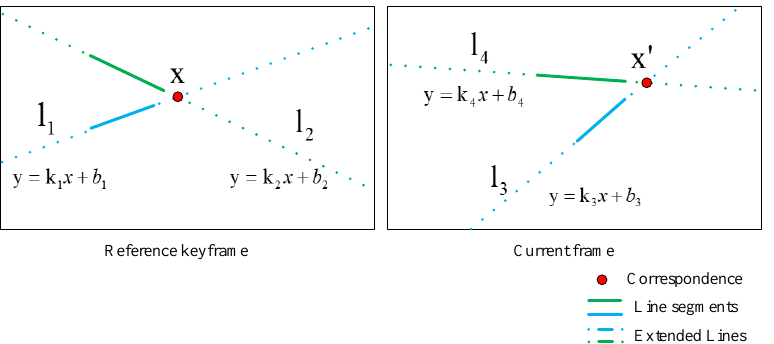
Figure 2. Illustration of the LSVI matching points. The line segments and the corresponding extended lines (shown in the same color) represent the matched line segments and the corresponding extended lines. k m ( m = 1,2,3,4 ) and b n ( n = 1,2,3,4 ) represent the slope and intercept of the line l m ( m = 1,2,3,4 ) , respectively. x and x (cid:48) represent a pair of